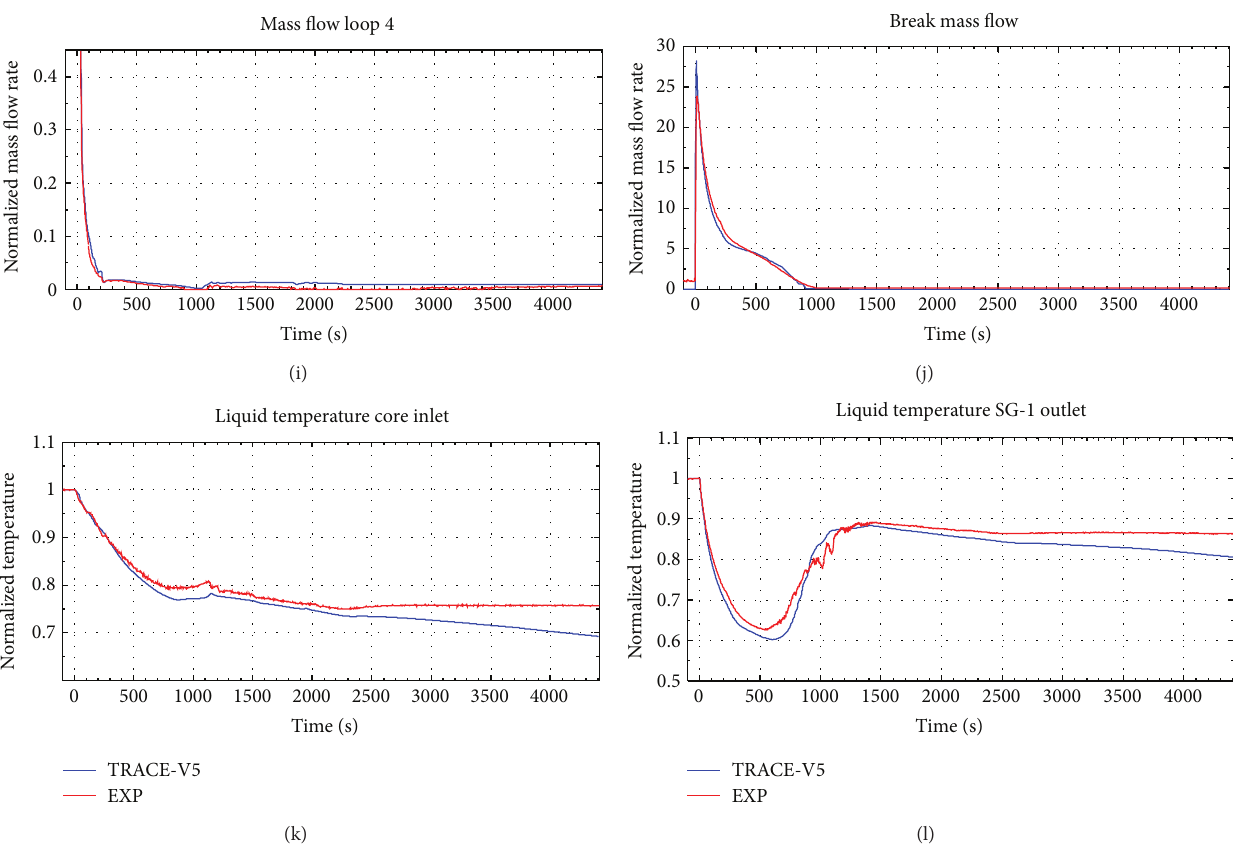
Figure 3: Parameter trends (normalized to SoT (start of transient) values), comparison among experimental data, and calculated results (part 1 of 2). Parameter trends (normalized to SoT), comparison among experimental data, and calculated results (part 2 of 2).